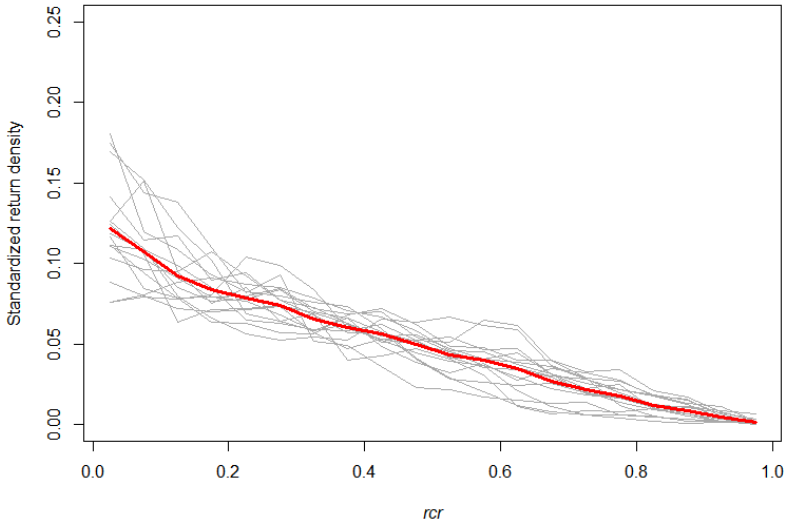
Figure 9. Standardized composite histogram ( SCH ) of the crown hits from TLS for the 17 scanned sample trees (grey lines). The red line represents the mean values obtained by LOESS.